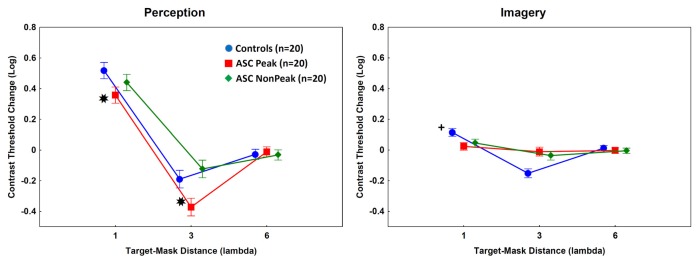
Mean log-contrast threshold changes (masks present minus isolated target stimuli). Error bars denote 95% confidence intervals. Negative values indicate facilitation by masks (lower contrast threshold for the target when the masks are presented relative to an isolated target). Perception: *Contrast threshold changes were significantly lower in the ASC Peak group (people with ASC exhibiting a Block Design peak performance) relative to the control individuals at 1λ and 3λ [Tukey’s Honestly Significant Difference (HSD) tests, ps < 0.01]. Imagery: +The ASC Peak and ASC Non-Peak (people with autism spectrum disorders exhibiting an average Block Design performance) groups showed weaker inhibition at 1λ (lower contrast threshold changes) and weaker facilitation (higher contrast threshold changes) at 3λ relative to the controls (Tukey’s HSD tests, ps < 0.01).